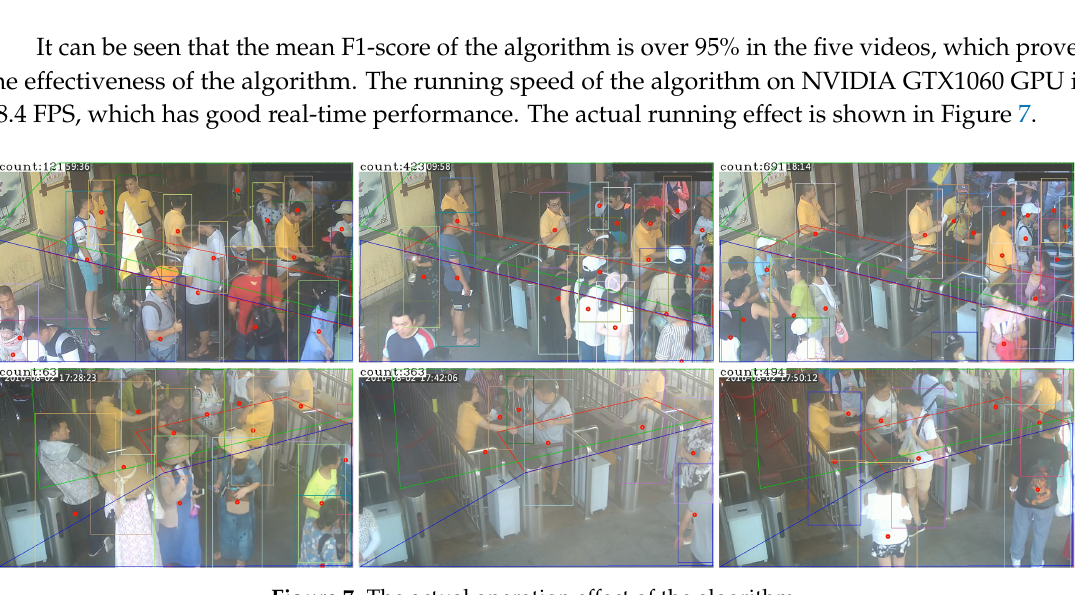
Figure 7. The actual operation effect of the algorithm.